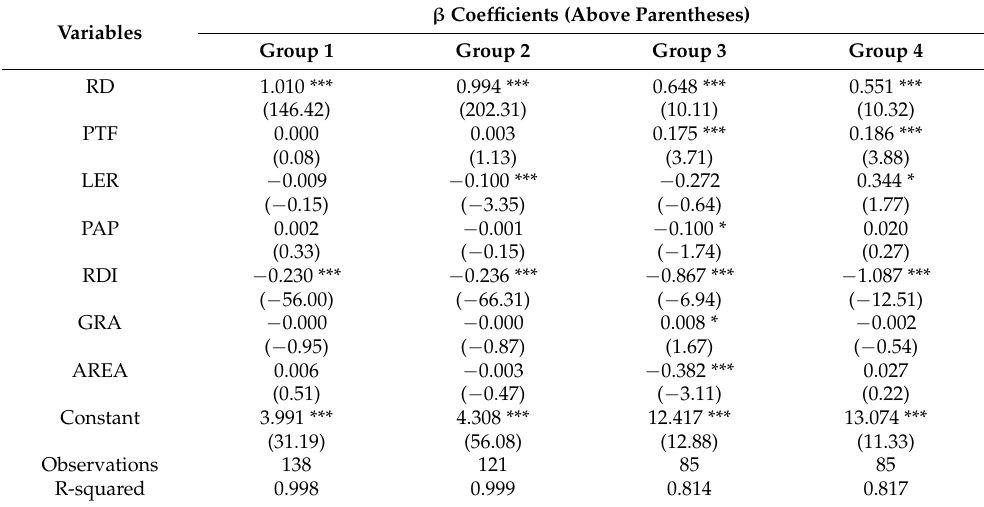
Table 6. Regression results of sub-groups for different regulations (Model